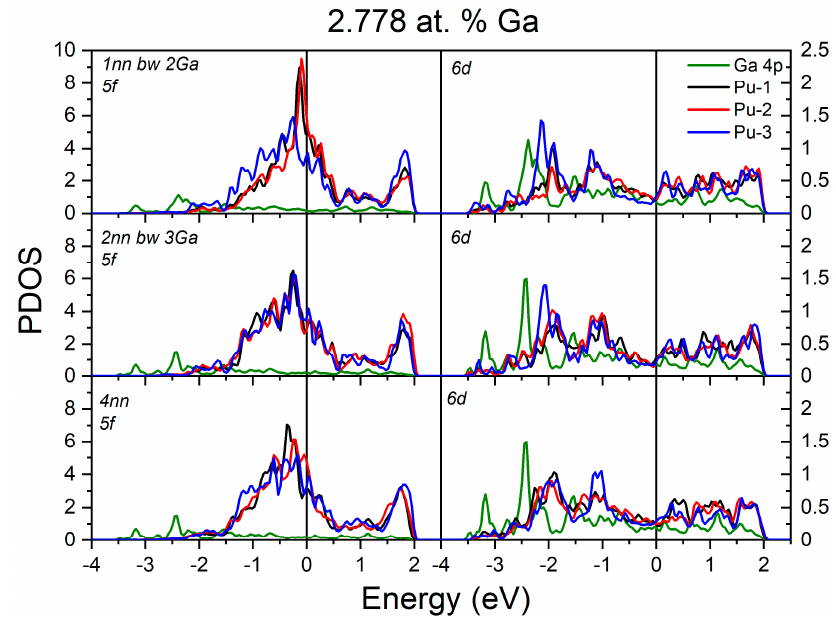
Figure 10. Partial density of states for 2.778 at. % Ga concentrations with a mono-vacancy at the first nearest neighboring distance between two Ga atoms (1nn bw 2 Ga), the second nearest neighboring distance between three Ga atoms (2nn bw 3 Ga), and the fourth nearest neighboring distance (4nn) from the Ga. The Pu 5f6d states shown for Pu atoms at various distances from the Ga atom (Table 3).